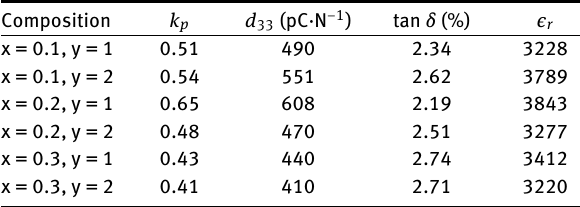
Table 1: Electric properties of PNN-PZT ceramics.